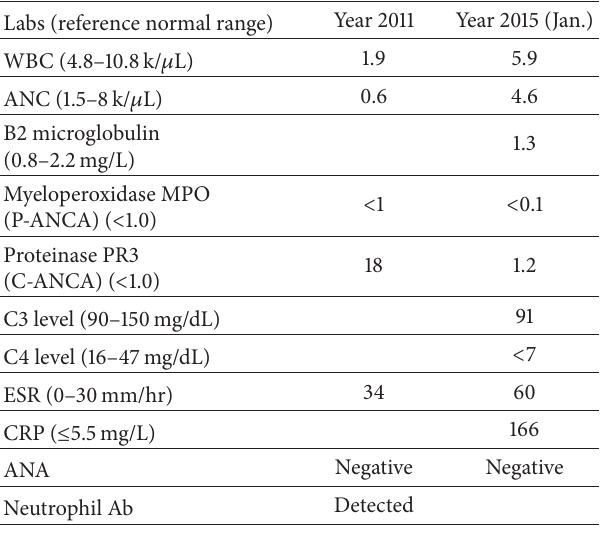
Table 1: Laboratory workup.